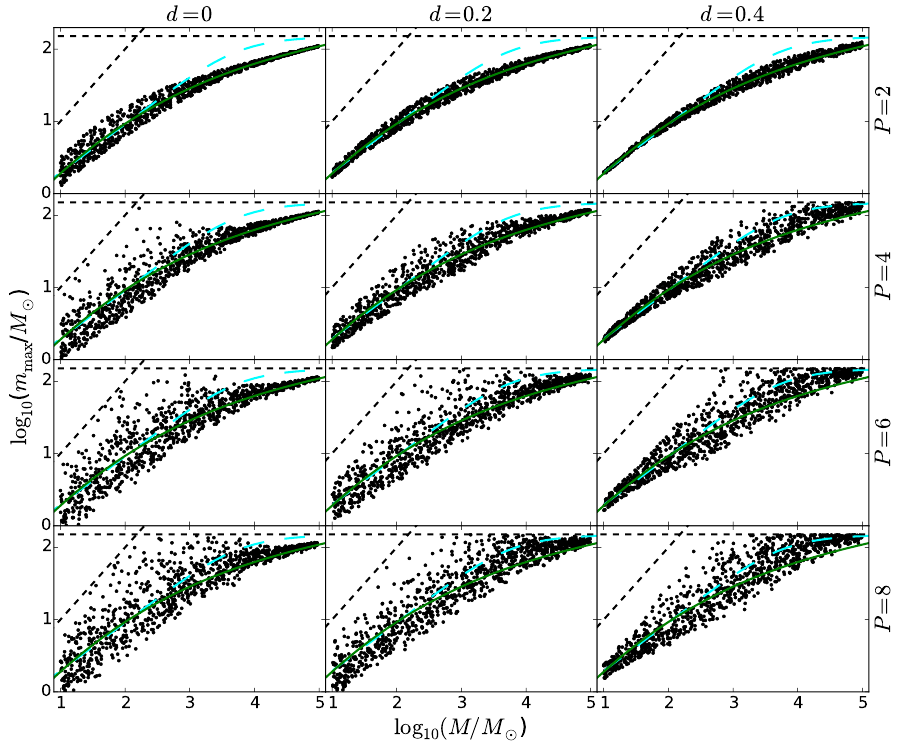
Fig.4. Dependence of the stochasticity affecting the most massive stars of star clusters on the power-law index d (indicated on the top) and on the expansion factor P (indicated at the right of the figure). The first column of the panels presents the sampling when no correction is taken into account, d = 0, while the central and right columns show the sampling generated with a growing correction. Each panel contains 1000 model